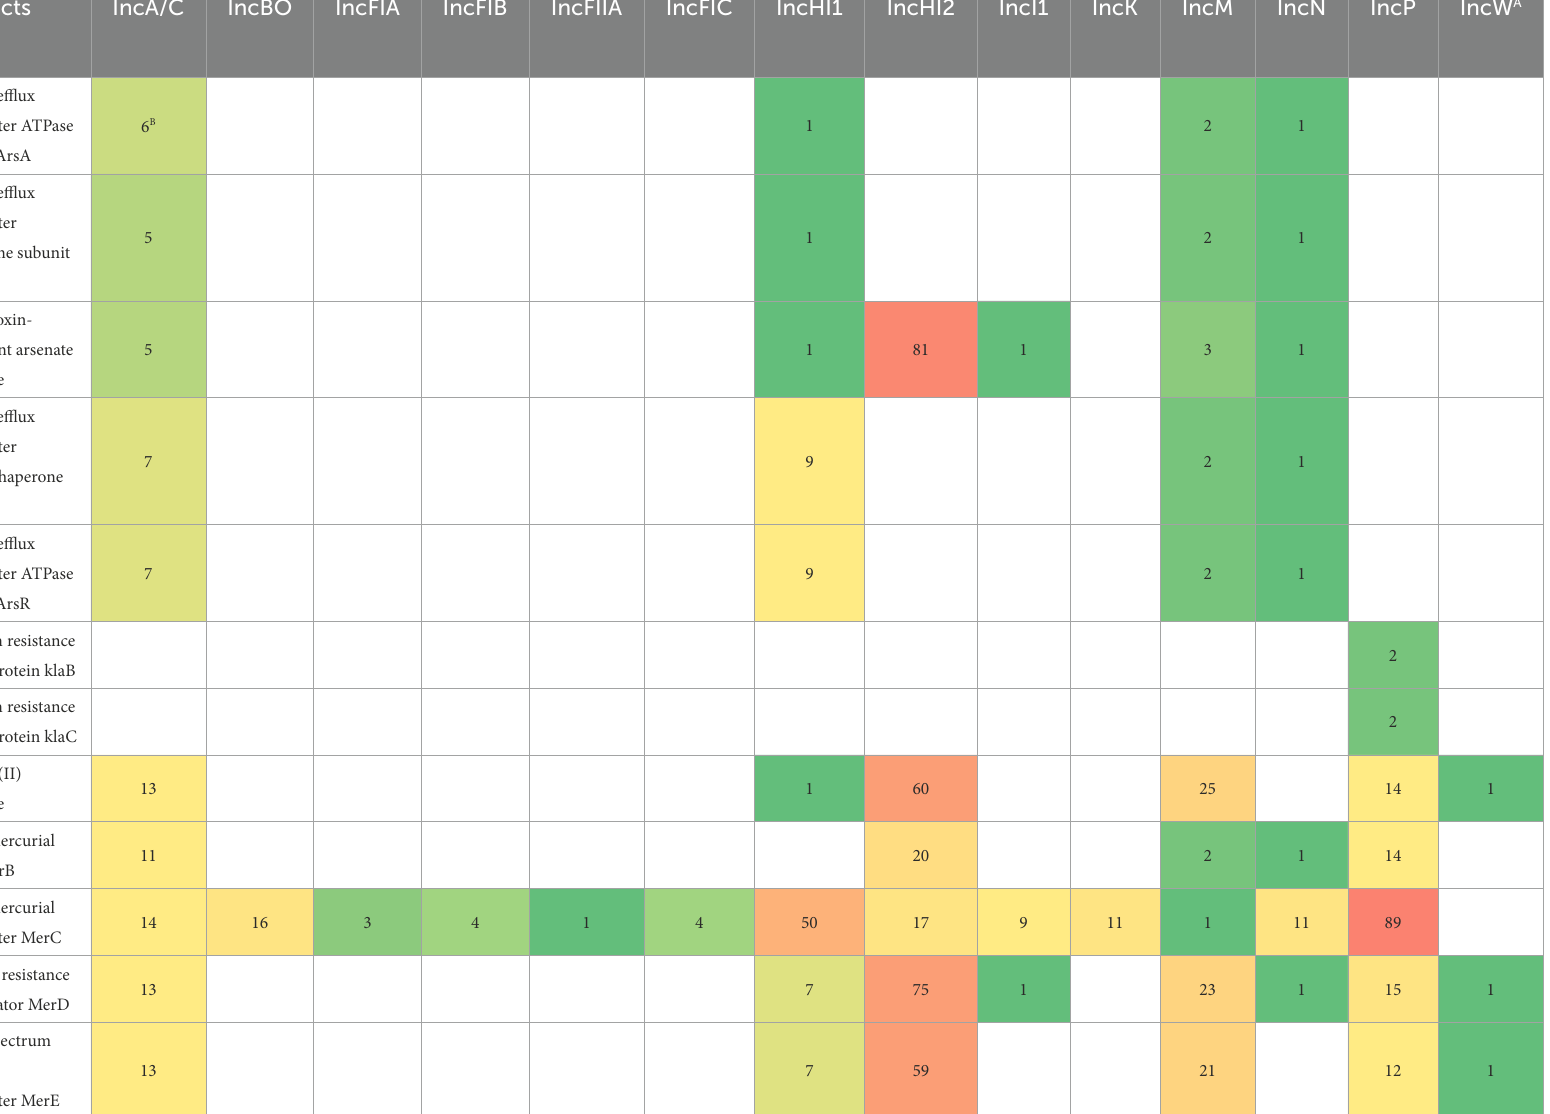
TABLE 3 Heavy metal resistance genes detected in 100 A representative sequences for each plasmid replicon type identified using AMRFinderPlus. Metal